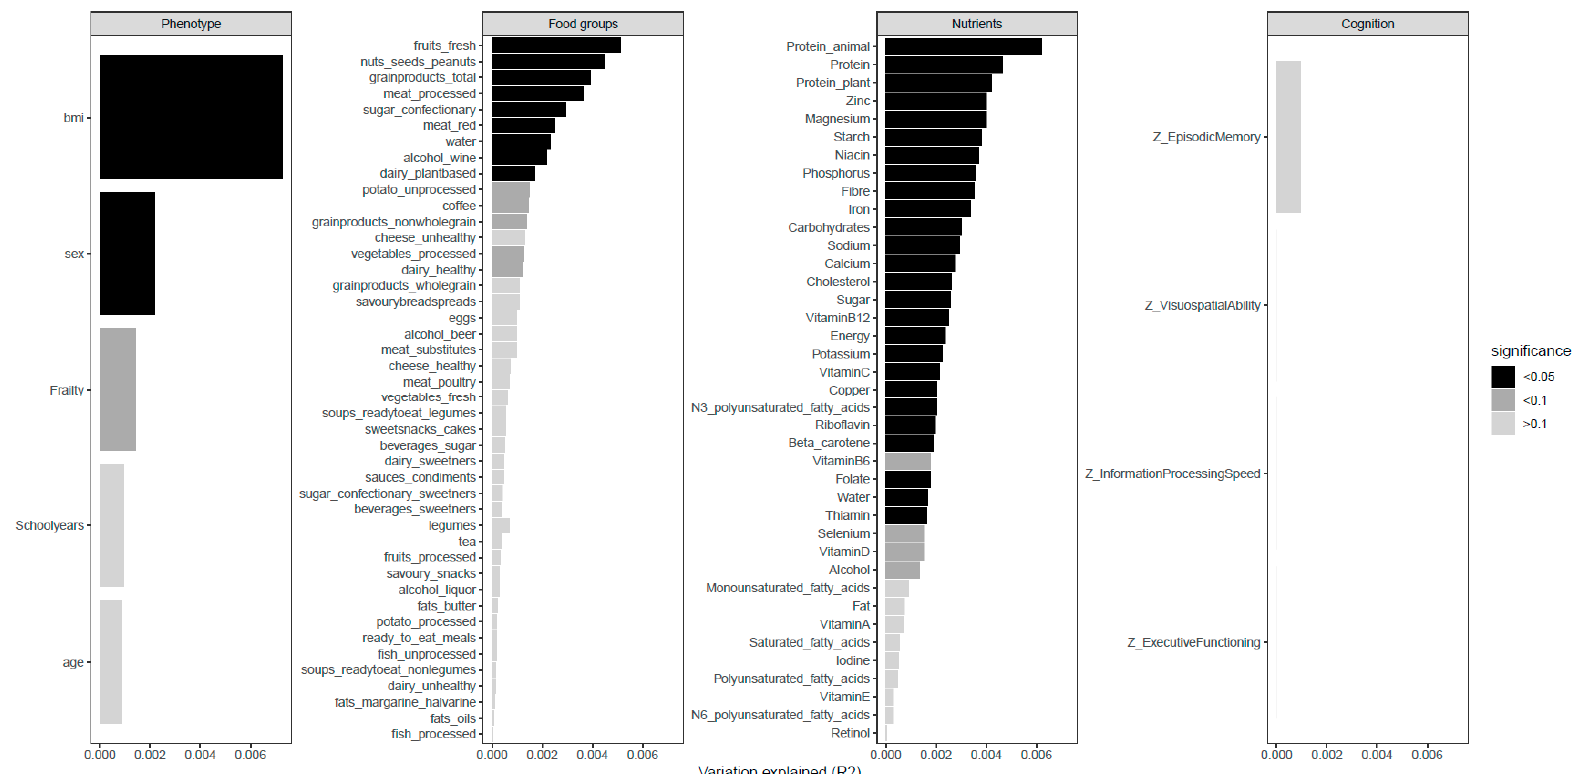
Figure 1. Microbiota covariates. Impact of all measured variables on microbiota composition defined as percentage variation explained (R 2 ) out of all the total microbiota variation. A higher R 2 implies a stronger effect size.